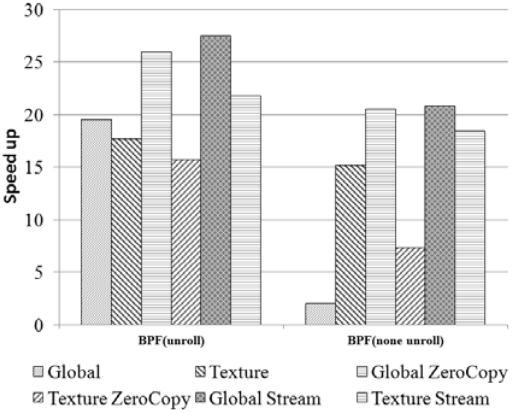
Fig. 10. Performance comparison between GPU-based BPF algorithms with unroll and non-unroll approaches.